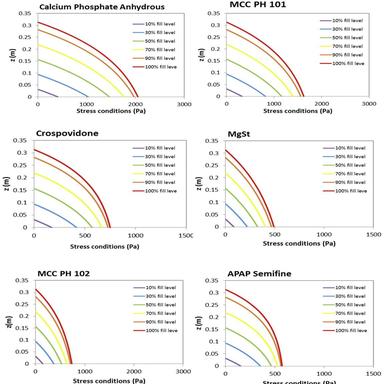
Distributions of vertical stress conditions as a function of the height of the feeder hopper and fill level for six materials, each representing respective clusters.